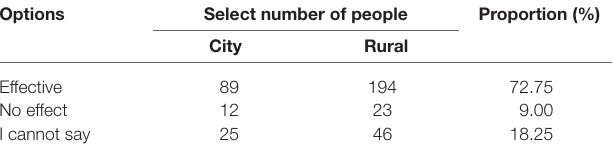
TABLE 5 | Questionnaire on perceptions of the role of discipline (students).